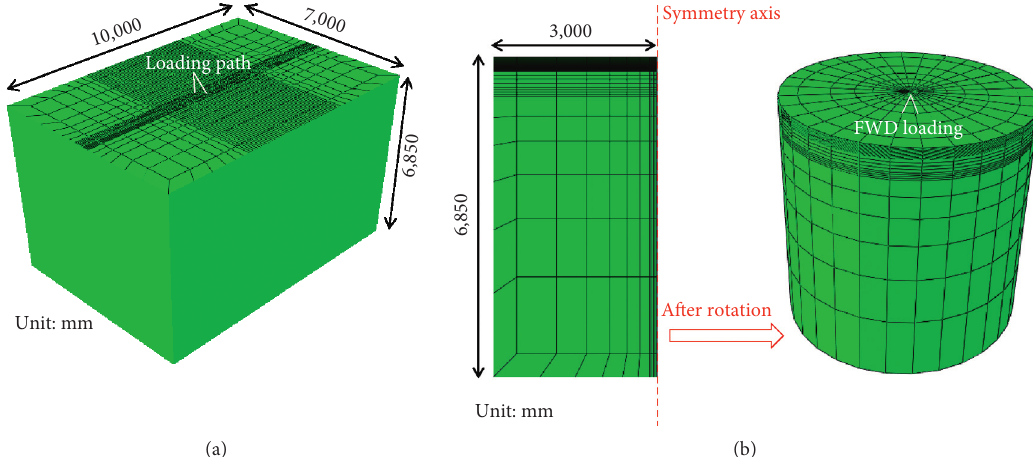
Figure 12: The FE models of the pavements under (a) vehicular loading and (b) FWD loading. Table 10: The thicknesses, moduli, and Poisson’s ratios of the modeled pavement structure layers. Pavement type